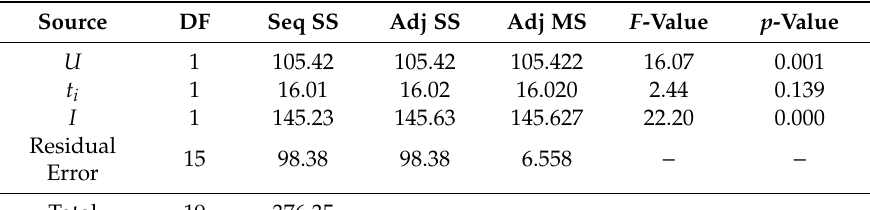
Table 7. ANOVA for the aspect ratio ( AR ).